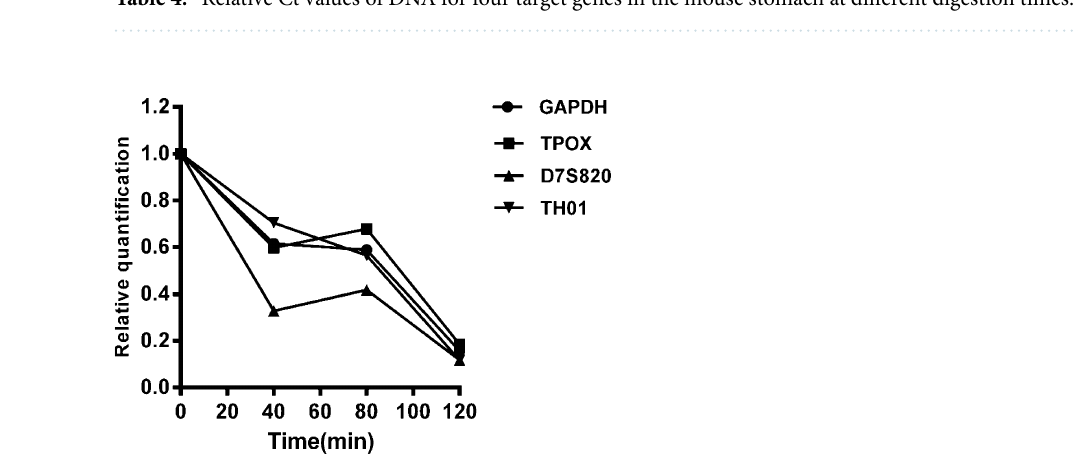
Table 4. Relative Ct values of DNA for four target genes in the mouse stomach at different digestion times.